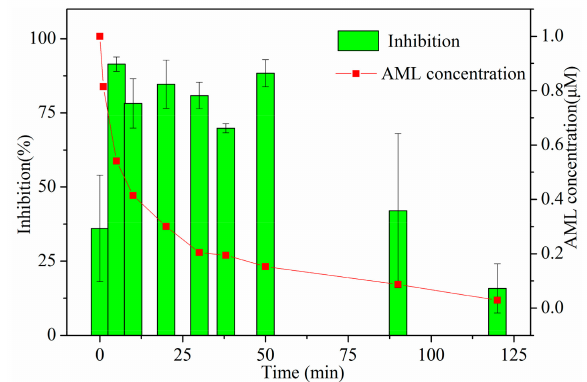
Figure 10. Inhibition rate of AML degradation by the UV / chlorine process on luminescent bacteria.